Question: According to this chart, does the measure grow or shrink?
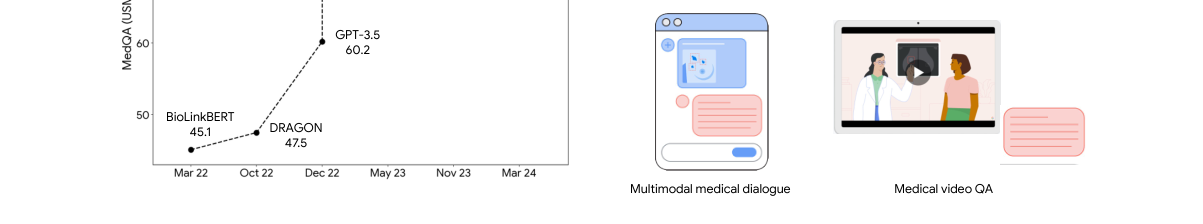
Answer: increasing